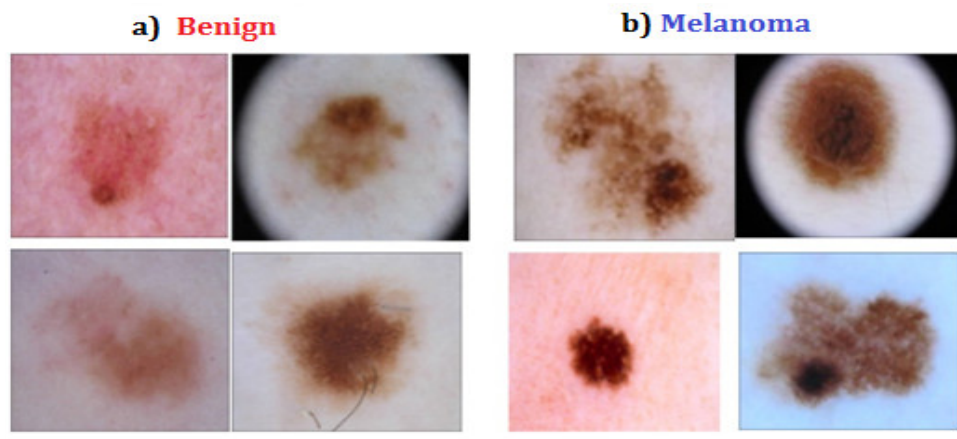
Figure 1. Representation for ( a ) “benign cancer” ( b ) “Melanoma”